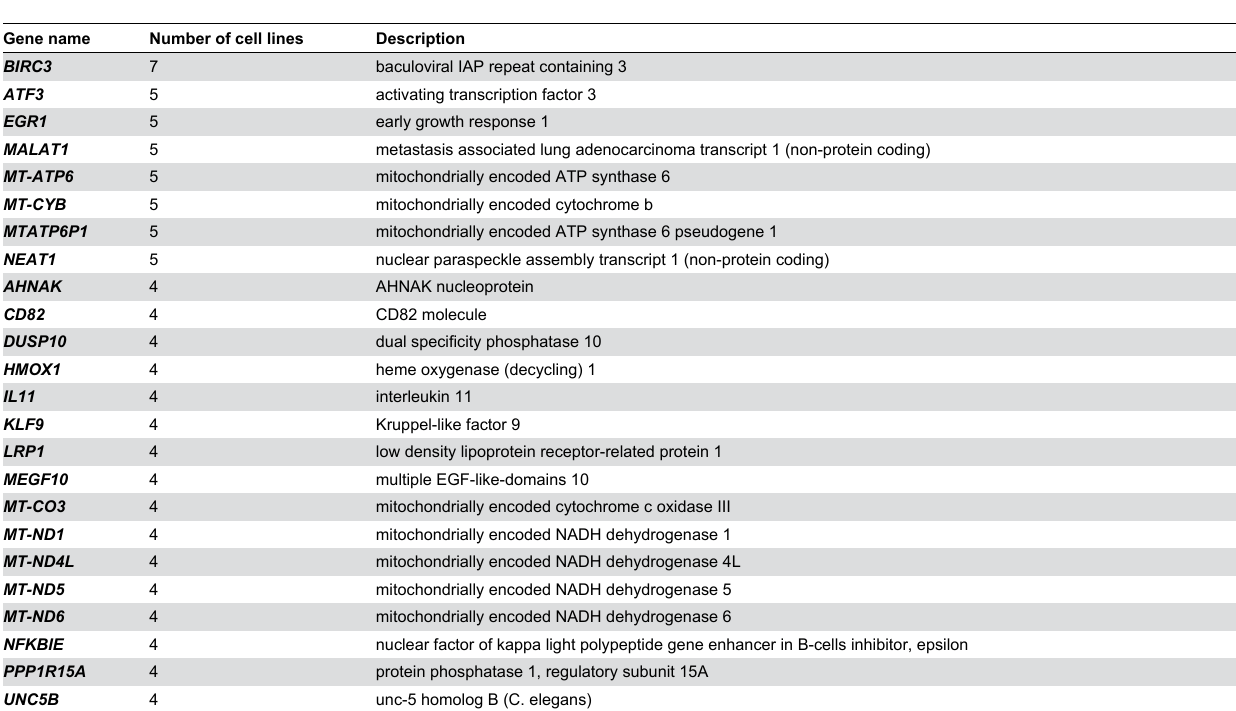
Table 1. Genes differentially expressed in four or more cell lines after RUNX2